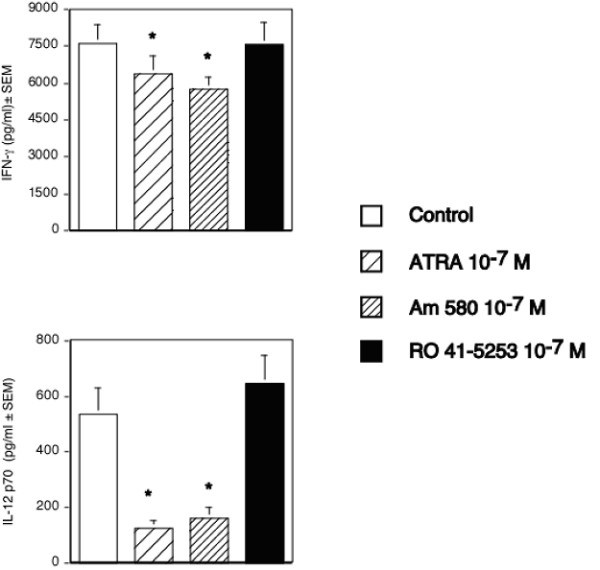
A RAR-α agonist specifically inhibits Th1-associated cytokine production by anti-CD3,-activated PBMC. IFN-γ (panel A) and IL-12p70 (panel B) proteins were quantitated by ELISA in supernatants of 48 h, anti-CD3,-activated PBMC treated with control EtOH, ATRA (10-7 M), AM580 (10-7 M), or an RAR- α antagonist, RO 41–5254 (10-7 M). The values shown represent the average obtained from 4 donors ± SEM. Means that express different superscripts are significantly different by at least p < 0.03.